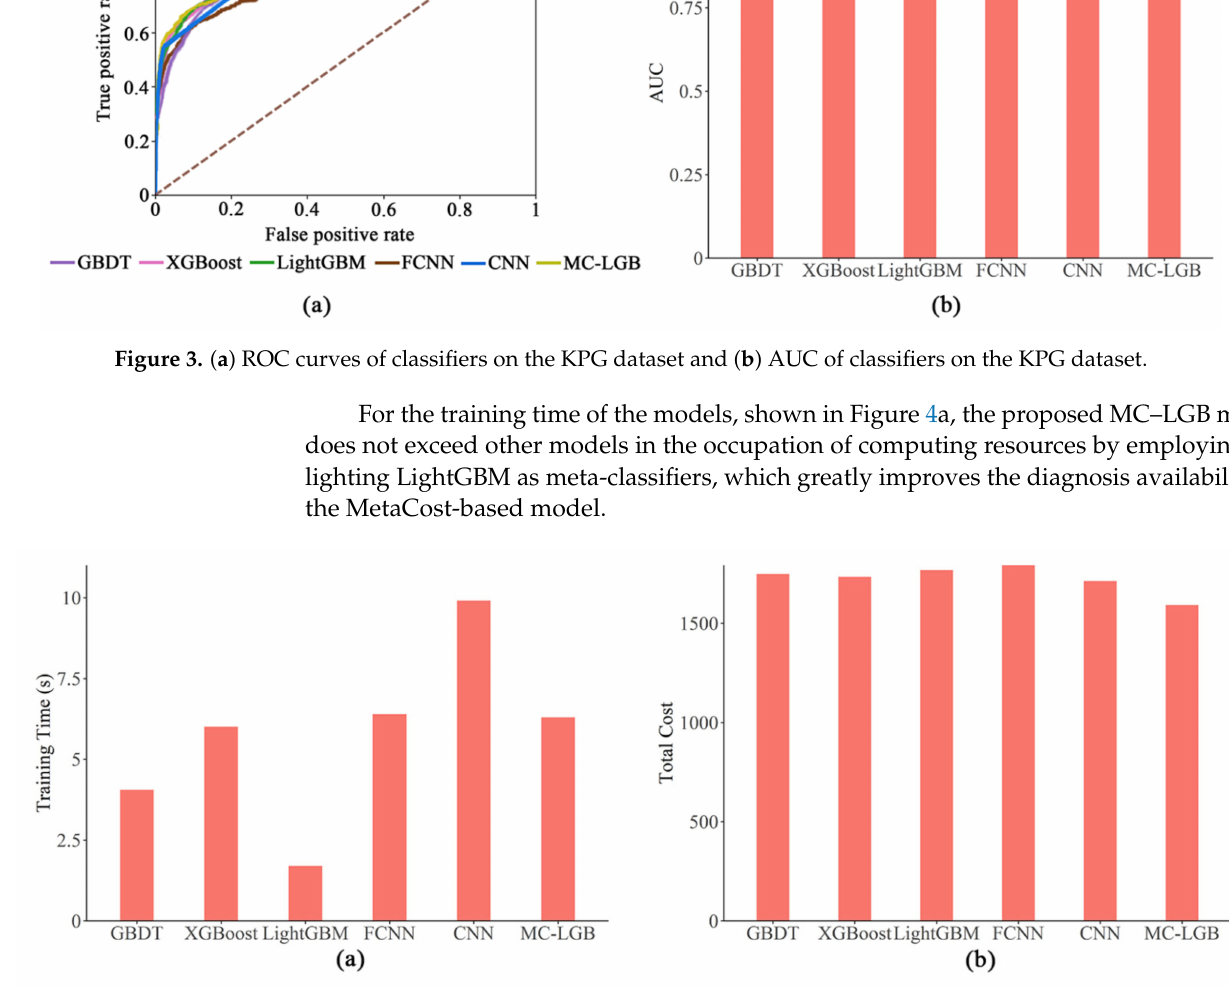
Figure 4. ( a ) Training time of classifiers on the KPG dataset and ( b ) total cost of classifiers on the KPG